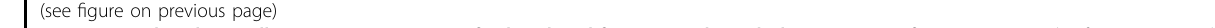
Fig. 5 GSTZ1 knockout cells are insensitive to sorafenib-induced ferroptosis through the activation of NRF2. A – D Levels of iron ( A , B ), and MDA ( C , D ) were assayed. GSTZ1-OE cells were treated with sorafenib alone or in combination with tBHQ (100 μ M for 3 h) (left). GSTZ1-KO cells were treated with sorafenib alone or in combination with Bru (40 nM for 24 h) (left). Expressing Flag-KEAP1 plasmid was transfected into GSTZ1-OE cells with sorafenib treatment (right). Expressing Myc-NRF2 plasmid was transfected into GSTZ1-KO cells with sorafenib treatment (right). E Representative images (top) and quanti fi cation (bottom) of ROS level in GSTZ1-OE cells treated with sorafenib alone or in combination with tBHQ (top) and GSTZ1- KO cells treated with sorafenib alone or in combination with Bru (bottom). Scale bar = 20 μ m. F 4-HNE-induced protein modi fi cation was examined. For western blotting, 50 μ g protein was loaded per well. tBHQ: tertiary butylhydroquinone, Bru brusatol, 4-HNE 4-hydroxy-2-nonenal. Values represent the mean ± SD ( n = 3). * p < 0.05, ** p < 0.01, *** p < 0.001, Student ’ s t -test (two